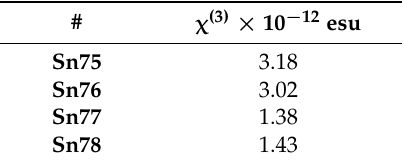
Table 10. Third order susceptibilities for Sn75–78 .